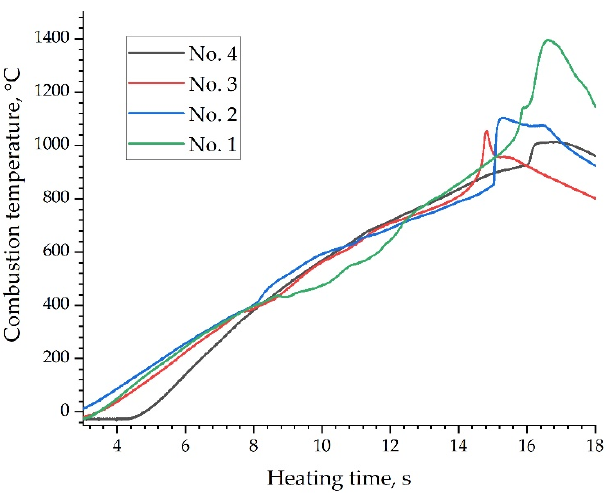
Figure 7. Typical ignition thermograms for the W/PTFE/Al system.